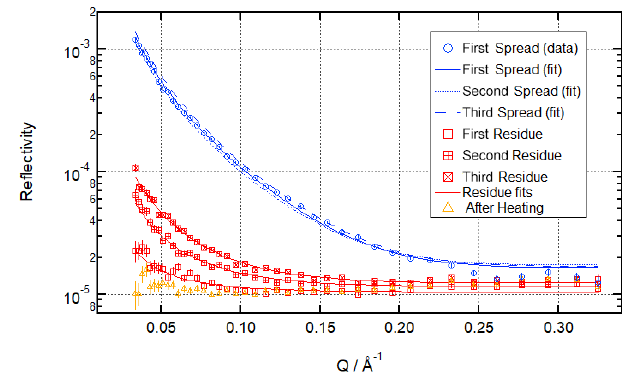
Figure 5. Neutron reflectivity signal from the air–water interface before ozonolysis (blue circles; data only shown for first spread- ing; fits shown for all three spreadings – clear and consistent signal from the oleic acid monolayers across the three simulated cook- ing emission peaks), after ozonolysis (red squares – demonstrating the build-up of organic residue at the air–water interface during re- peated exposure to cooking emission), and after heating (orange tri- angles – removal of organic residue at room temperature) for the multi-ozonolysis reaction shown as a time evolution plot in Fig.